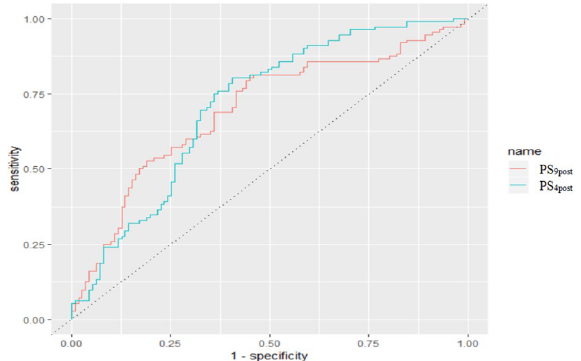
Figure 4. The ROC of PS9post and PS4post among postmenopausal women Note: The AUC of PS9post and PS4post was 0.696 and 0.712 (p = 0.52). The curve was conducted using R 3.5.1 software (R Core Team, Vienna, Austria, 2018. https:// www.R- proje ct. org/) and Microsoft EXCEL software (Microsoft, USA, 2016. https:// www. micro soft. com/ zh- cn/ micro soft- 365/ excel).